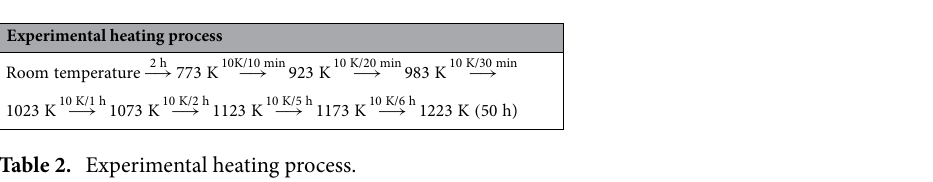
Experimental heating